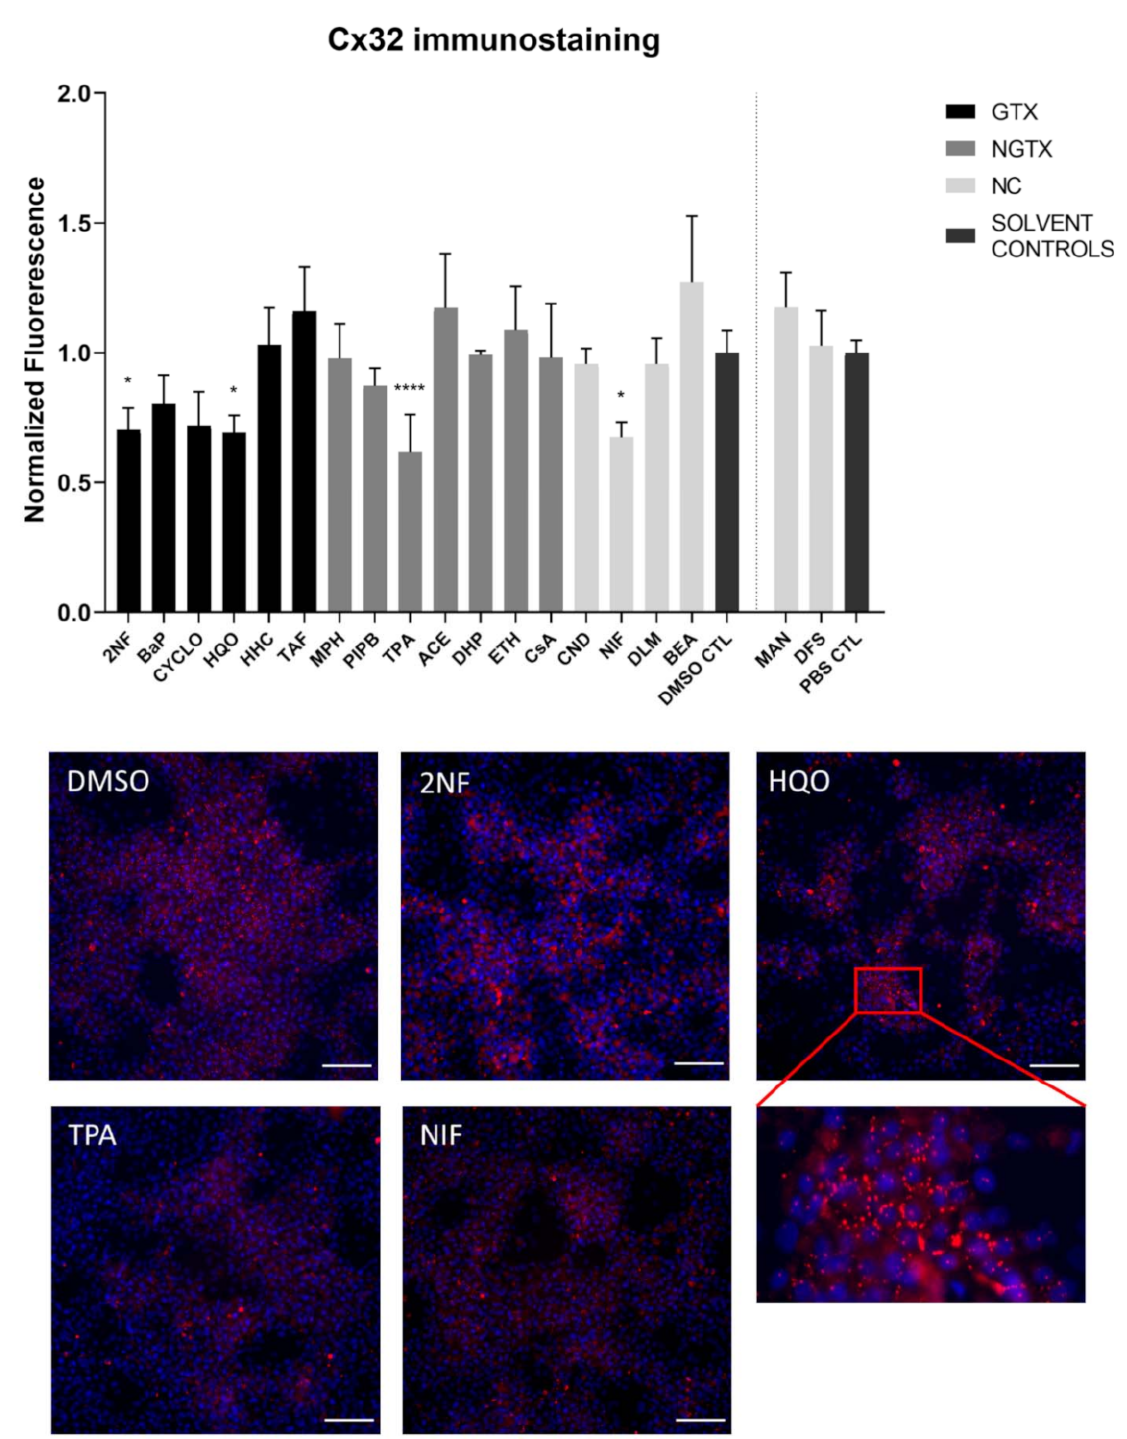
Figure 6. Cx32 protein localization in human hepatoma HepaRG cells exposed GTX, NGTX, and NC chemicals. Human hepatoma HepaRG cells ( n = 1 and N = 1; at least 3 images per well) were exposed to GTX, NGTX, and NC chemicals for 72 h. The area and intensity of the fluorescent signal was quantified via ImageJ software (version 1.52p, Bethesda, MD, USA) and normalized to the fluorescent signal of the respective solvent control (DMSO CTL or PBS CTL). Significant difference compared to the solvent control was calculated with a parametric one-way ANOVA followed by a Dunnett’s post-hoc test to correct for multiple comparisons. Data are expressed as mean ± standard deviation with * p ≤ 0.05 and **** p ≤ 0.0001. Only images of significantly affected chemicals are shown. Scale bar = 100 µ M, 20 ×